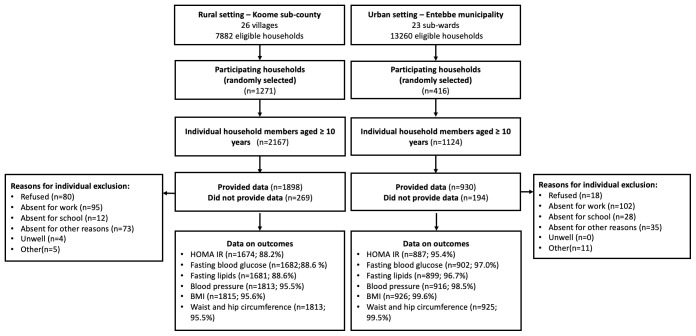
Study flow chart.